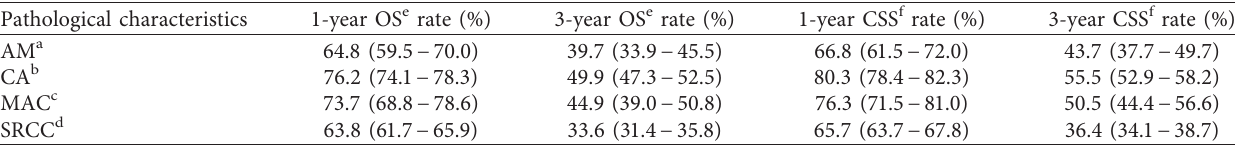
Table 4: 1-year and 3-year overall survival (OS) rates and cancer-specific survival (CSS) rates of patients with 4 histological subtypes (adenocarcinoma with mixed subtypes, classical adenocarcinoma, mucinous adenocarcinoma, and signet-ring cell carcinoma) in advanced gastric